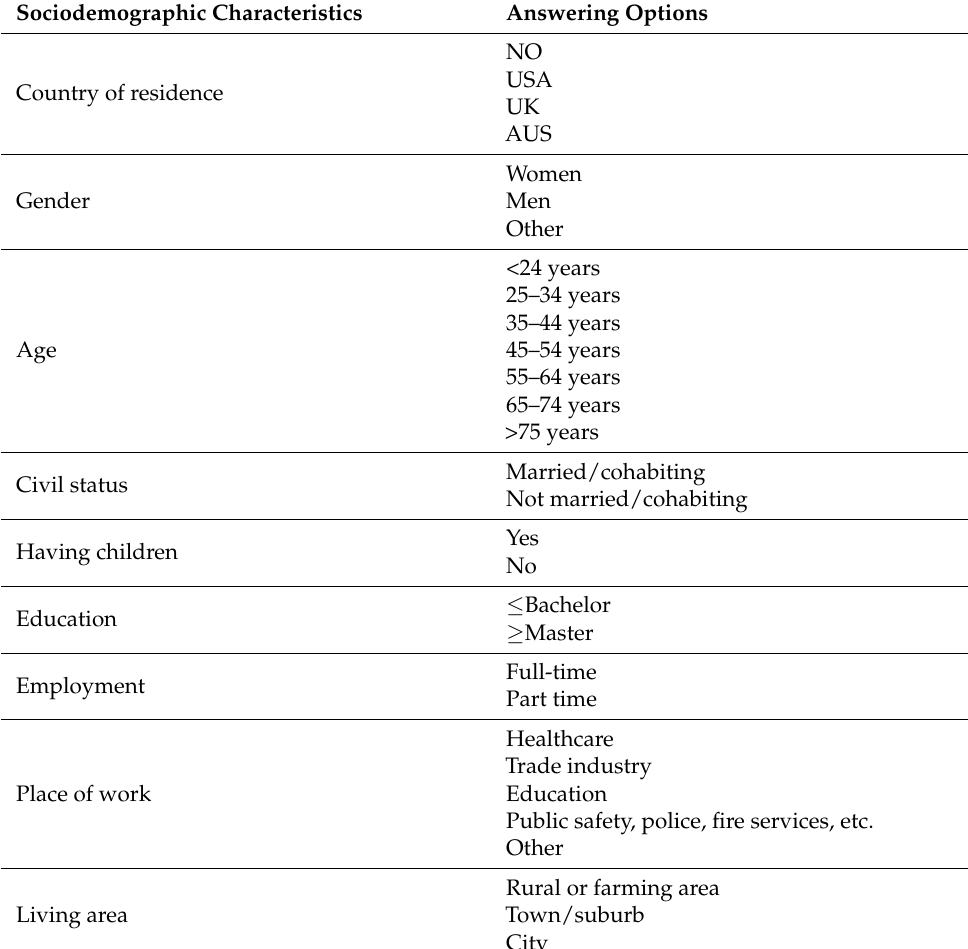
Table 1. Overview of the sociodemographic characteristics. Sociodemographic